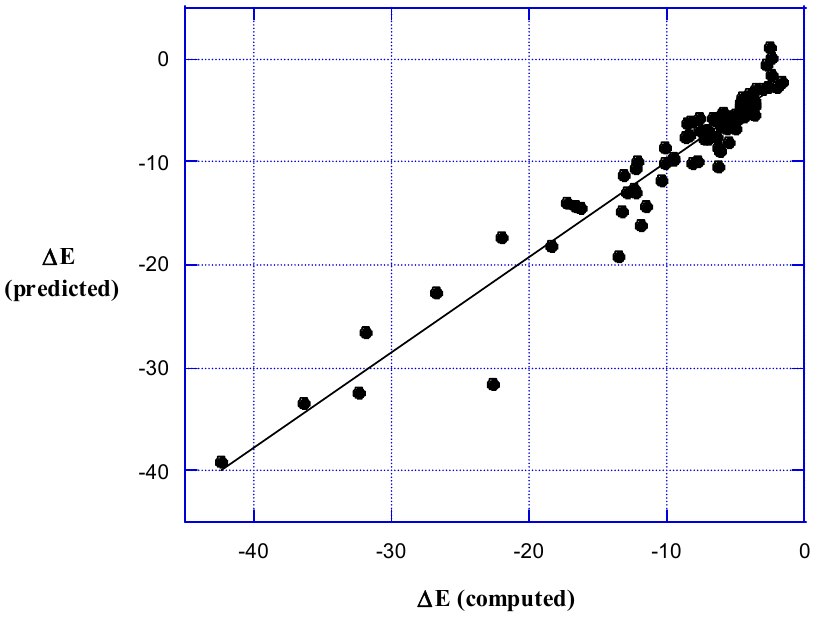
Figure 5. ∆ E predicted with Equation (4) plotted against the computed ∆ E, in kcal / mol, for all of the σ - Figure 5. Δ E predicted with Equation (4) plotted against the computed Δ E, in kcal/mol, for all of the and π -hole interactions in Tables 1 and 2. R 2 = σ - and π -hole interactions in Table 1; Table 2. R 2 = 0.927.